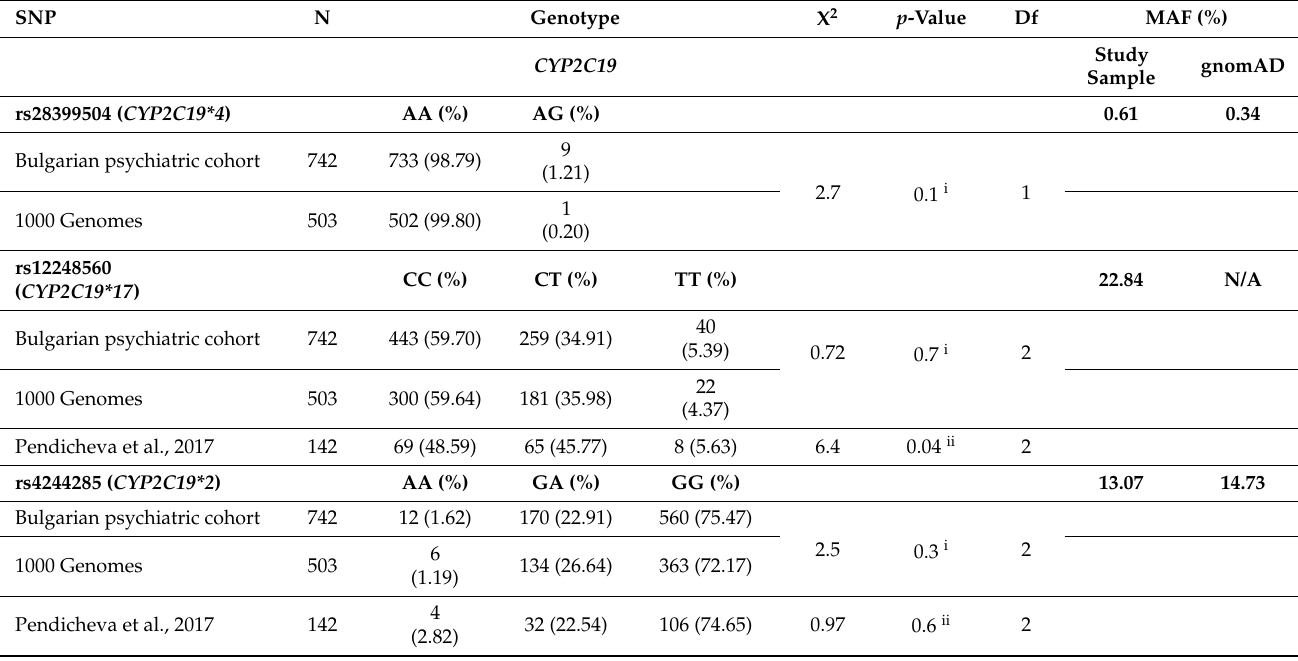
Table 1. Haplotype and diplotype frequencies of CYP2C19 .